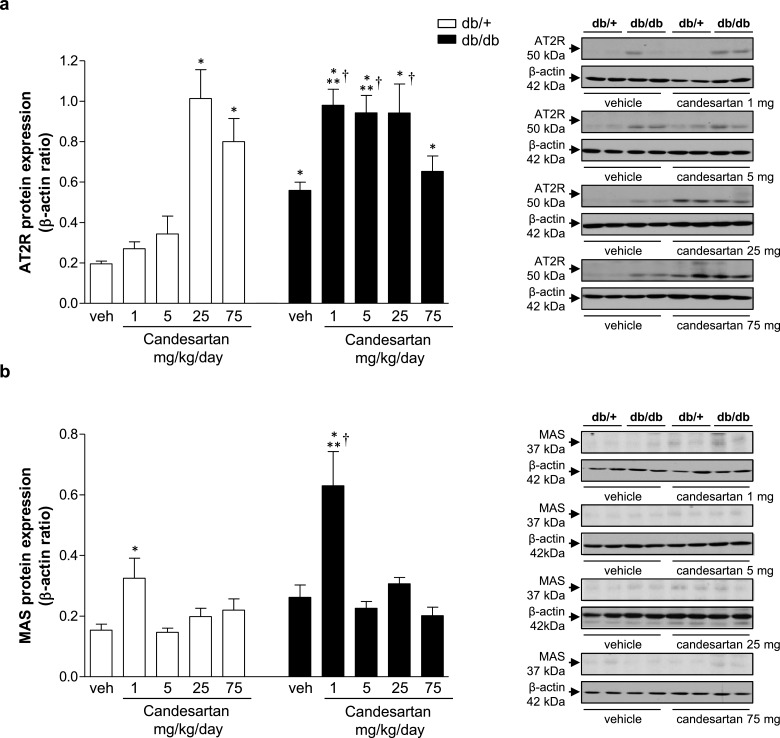
Candesartan modulates expression of RAS receptors in kidney cortex from db/db miceProtein expression of AT2R (a) and Mas receptor (b) in kidney cortex from db/+ and db/db mice treated with vehicle or candesartan (1, 5, 25 or 75 mg/kg/d). Side panels, representative immunoblots of AT2R, Mas receptor and β-actin. Results are presented as mean ± S.E.M. of 5–7 mice. *P<0.05 compared with vehicle-treated db/+; **P<0.05 db/db compared with db/+ of corresponding candesartan dose; †P<0.05 candesartan-treated db/db compared with vehicle-treated db/db.